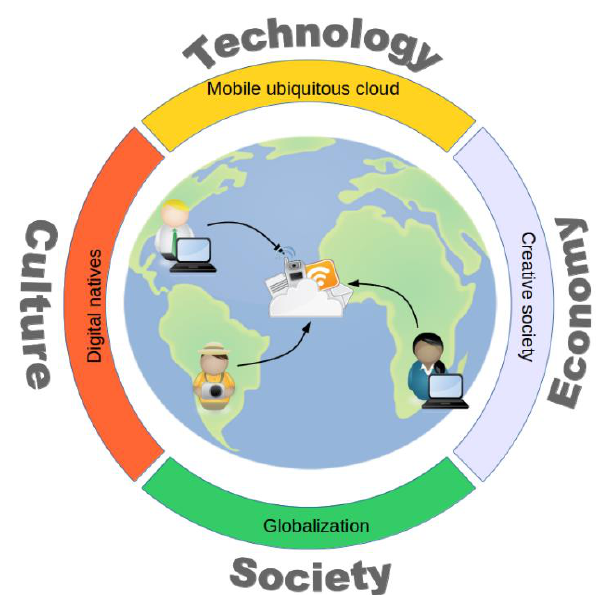
Figure 1 . Overview of the context in which MOOCs come about. To fully understand the potential